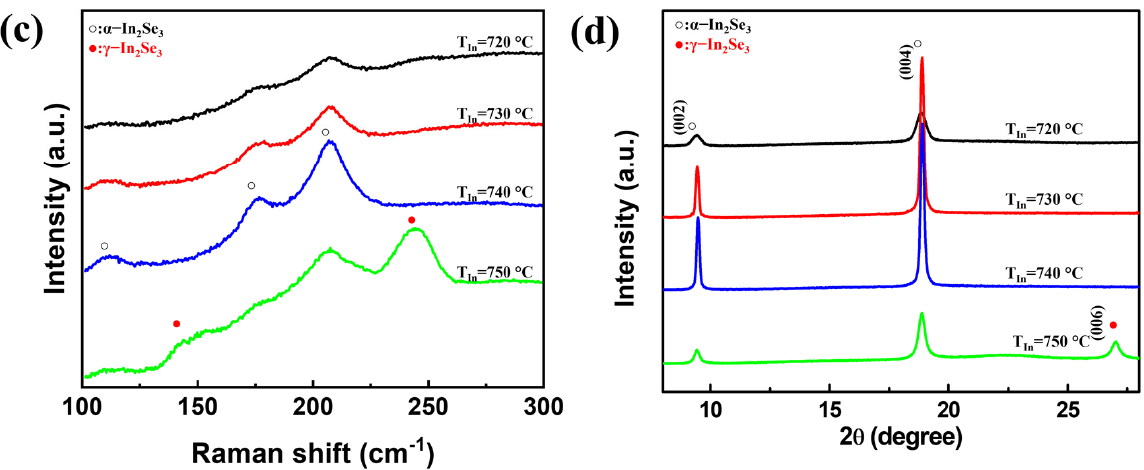
Figure 1. ( a ) The process flow of In 2 Se 3 growth. ( b ) The RHE ED patterns of In 2 Se 3 along with [1010] (on the left ) and [112 0] (on the right ) arimuth of T In varied at 720 ◦ C, 730 ◦ C, 740 ◦ C, and 750 ◦ C, respectively. ( c ) Raman spectra and ( d ) XRD θ -2 θ scans of In 2 Se 3 films with various T In temperatures.